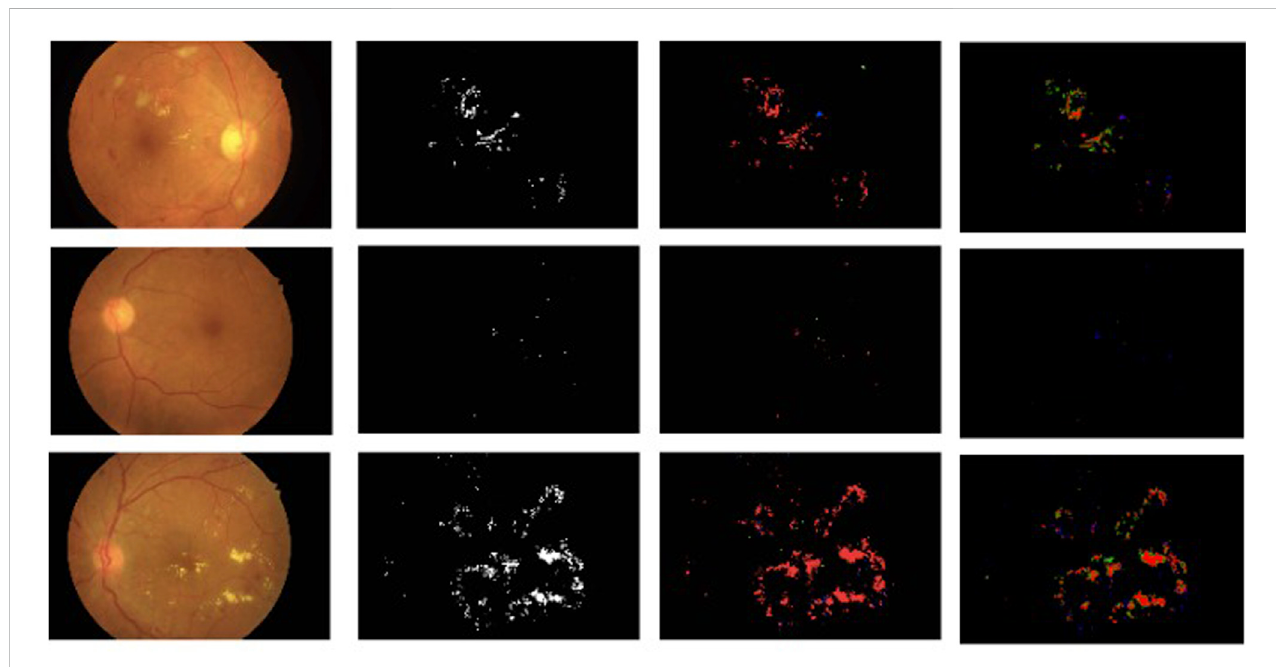
FIGURE 13 Comparison of the proposed approach for segmentation of exudates with results of Guo et al. (2020). Each column from the left shows the original image, the ground-truth segmentation results of Guo et al. (2020), and the segmentation results of our proposed approach. The color code is the same as in Guo et al. (2020): red, true positive; green, false positive; blue, false